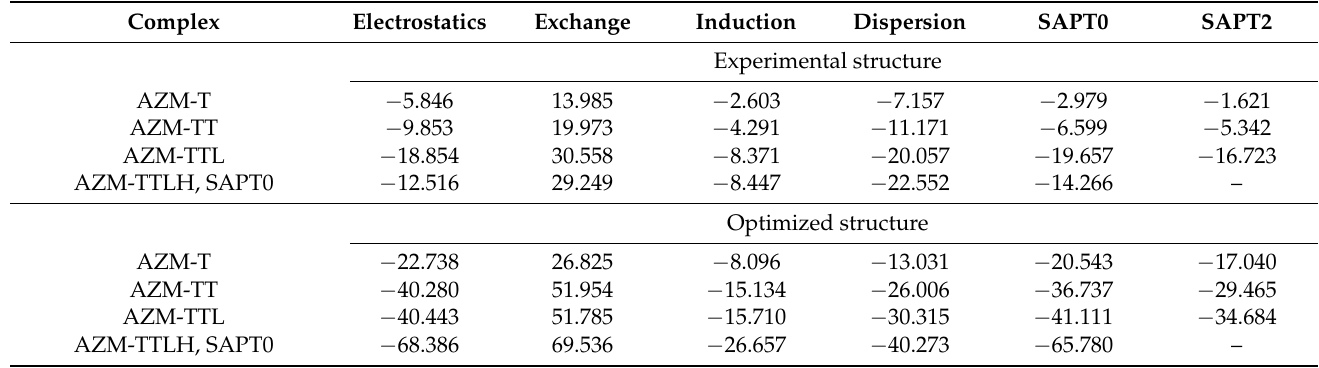
Table 2. Interaction energy partitioning (in kcal/mol) obtained at the SAPT0/aug-cc-pVDZ and SAPT2/aug-cc-pVDZ levels of theory. The exception was the AZM-TTLH complex, which was too large to compute its energies at the SAPT2 level of